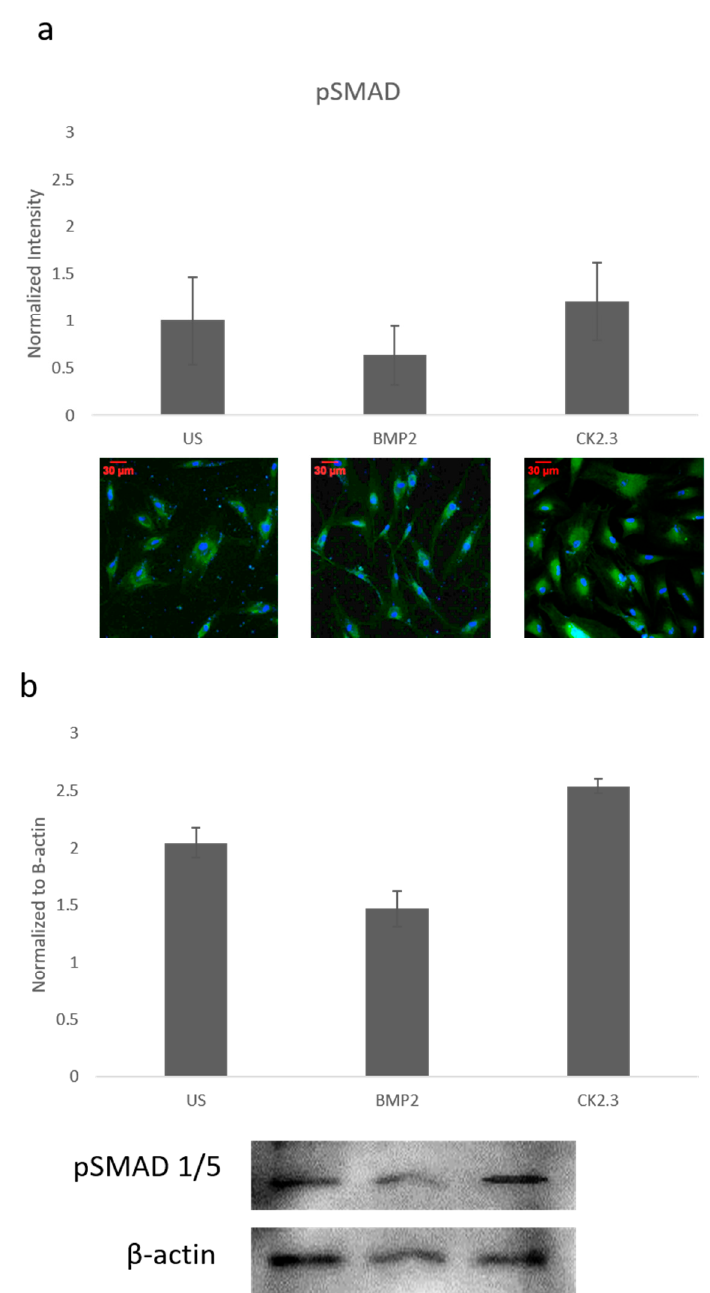
Figure 2. Mature osteoblasts were extracted from OP patients and stimulated with BMP2, CK2.3 or were left US for five days. On the fifth day, cells were fixed and fluorescently stained for pSMAD (green) and the nucleus (blue). ( a ) pSMAD fluorescent intensity remains unchanged under all stimulations, while BMP2 stimulation indicates a slight decrease in expression, this was not significant. ( b ) Lysates were also collected from extract osteoblasts from OP patients and run on an SDS-Page gel to separate the proteins. The separated proteins were then transferred onto an immunoblot and pSMAD and β -actin protein levels were detected. Expression was detected through densiometric analysis. BMP2 stimulation seems to decrease pSMAD expression, but this difference was not significant. Error bars represent standard error of the mean (SEM). ( p < 0.05).